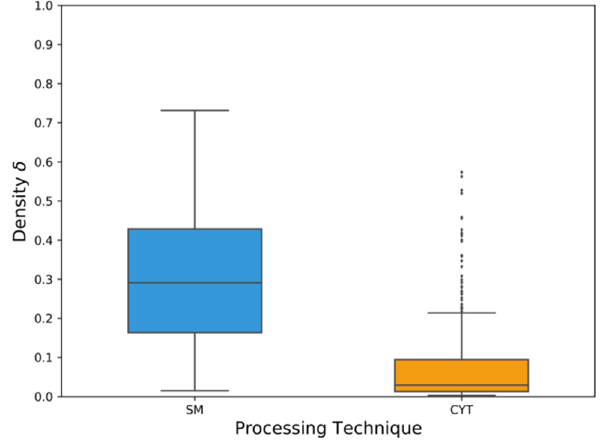
Figure 8. Density distributions comparison.